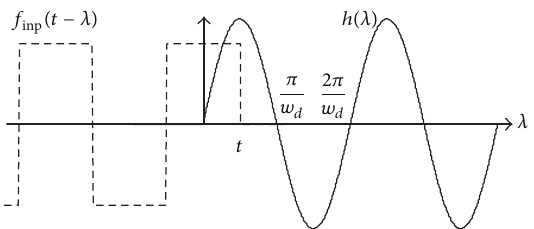
Figure 13: The rectangular wave at the input.